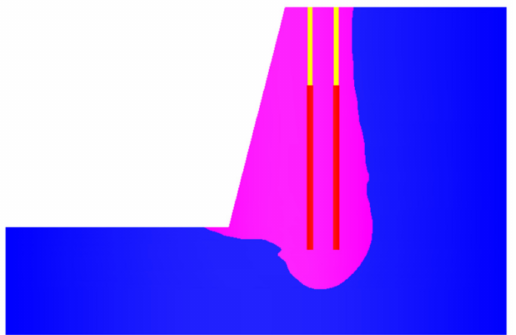
Figure 3. Blasting rupture range based on the proposed damage